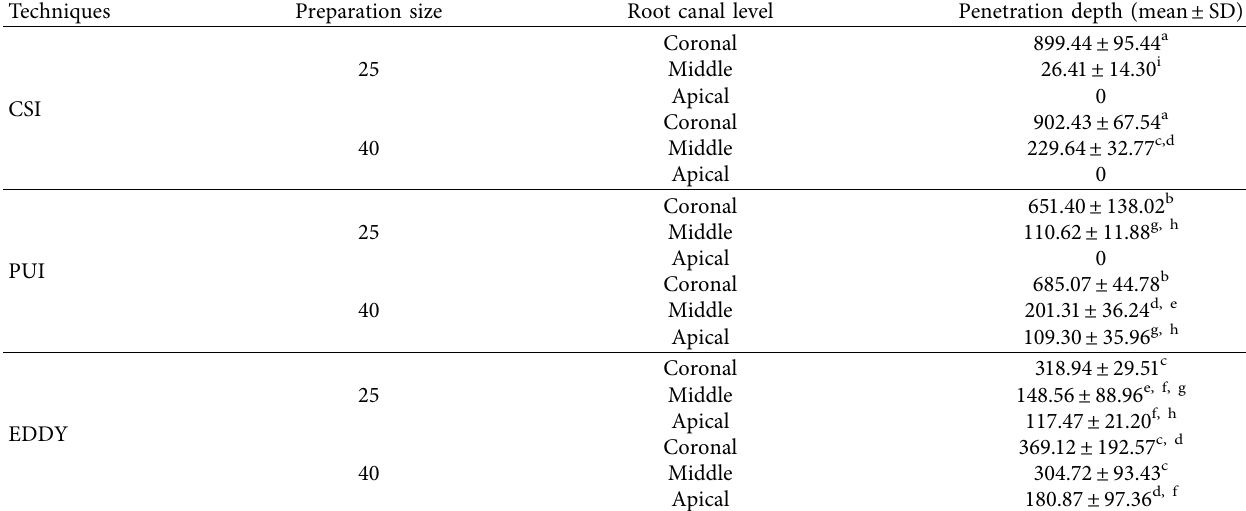
Table 1: The penetration depth of sodium hypochlorite into the dentinal wall of the root canal. Means sharing the same superscript are not significantly different from each other ( p ≥